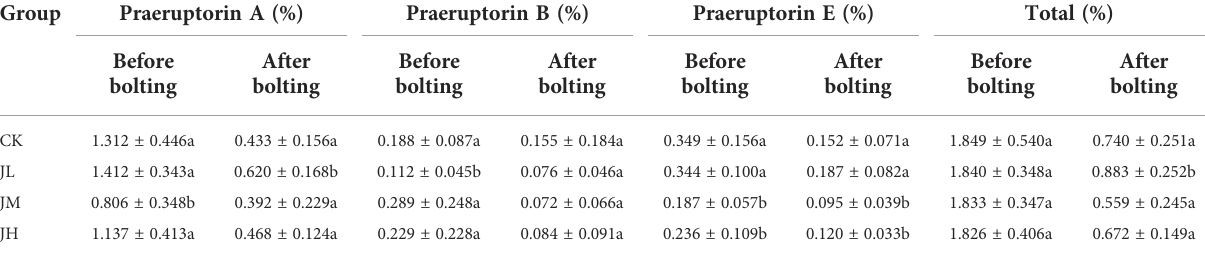
TABLE 3 Content of coumarins in different groups of Qianhu (n=9, mean ± SD). Group